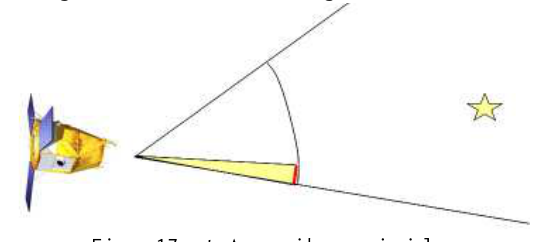
Figure 17 : starAcq guidance principle